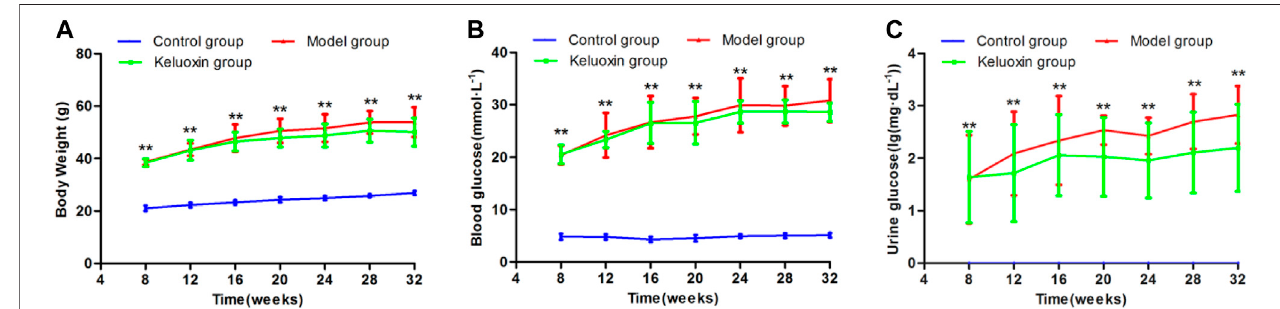
FIGURE 1| Changes in BW, blood glucose level, and urine glucose level of the control, model, and KLX-treated groups. (A) Change in BW during treatment ofDR withKLX. (B) ChangeinbloodglucoselevelduringtreatmentofDRwithKLX. (C) ChangeinurineglucoselevelduringtreatmentofDRwithKLX.Valuesarepresentedas mean ± SEM ( n = 10 per group). Data were analyzed by Student ’ s t-test. Model group data were compared with control group data over the same period; ** p < 0.01. BW, body weight; KLX, keluoxin; DR, diabetic retinopathy.